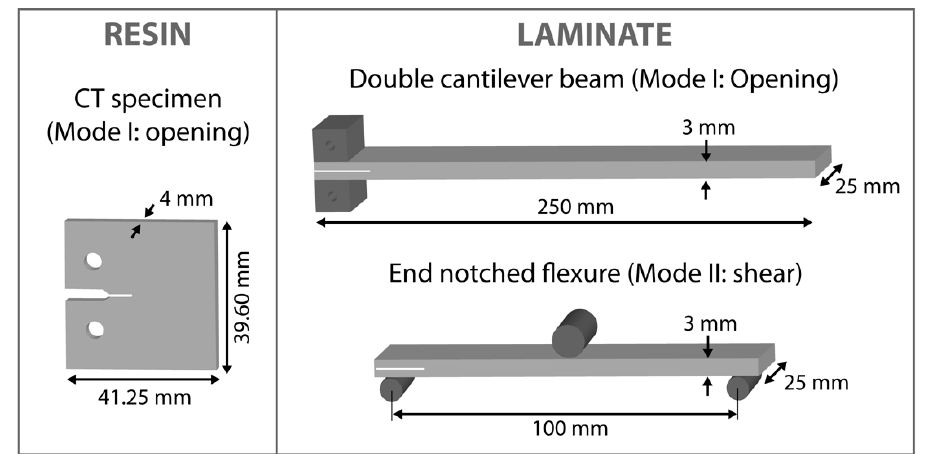
Figure 3. Geometries of specimen for evaluation of fracture toughness in resin and laminates.